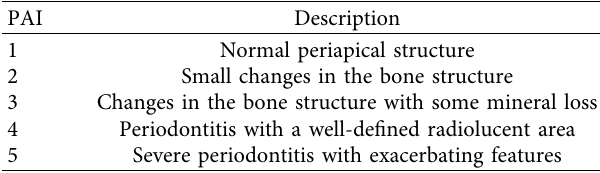
Table 3: Description of the PAI scoring system [10].